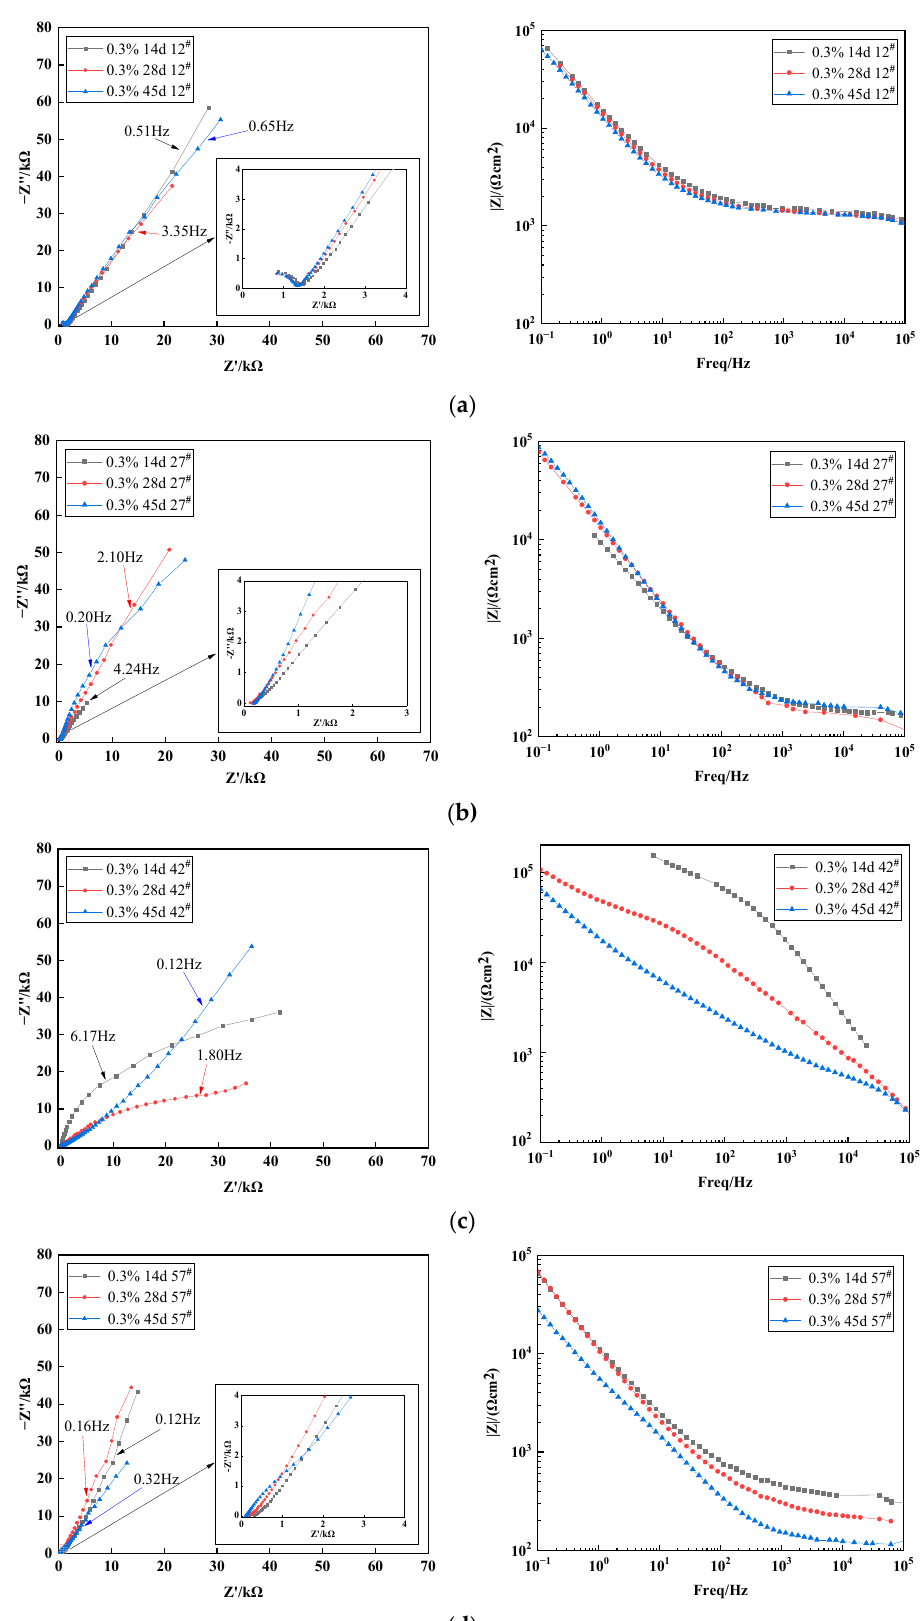
Figure 12. Nyquist and Bode plots of X70 steel in soil column with 0.3% sodium chloride: ( a ) 12 # , ( b ) 27 # , ( c ) 42 # , and ( d ) 57 #